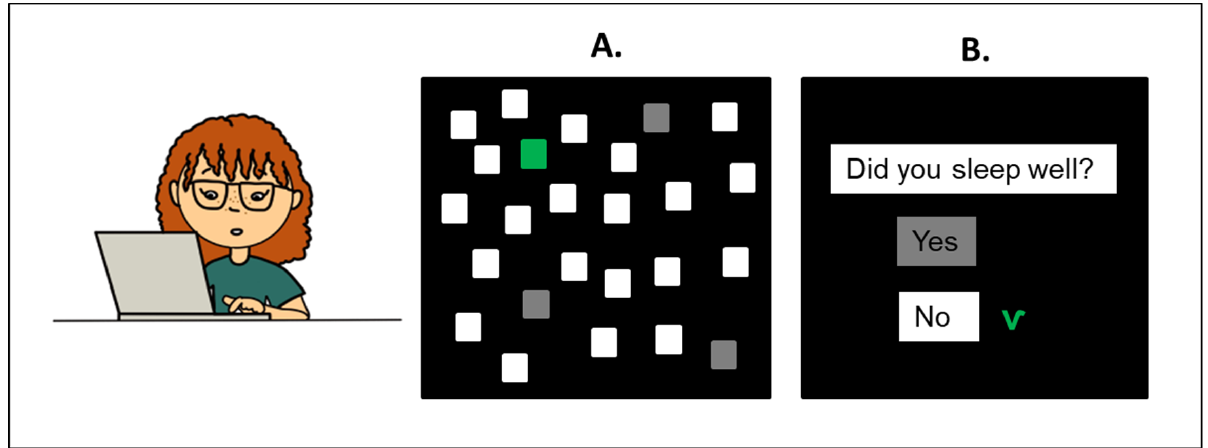
Figure 1. Computer tasks: ( A. ) Visual Attention Task. 3-min task to test the response time. The green squares had to be clicked consecutively with the mouse cursor. ( B .) Behavior questionnaire (an example of questions and answers).